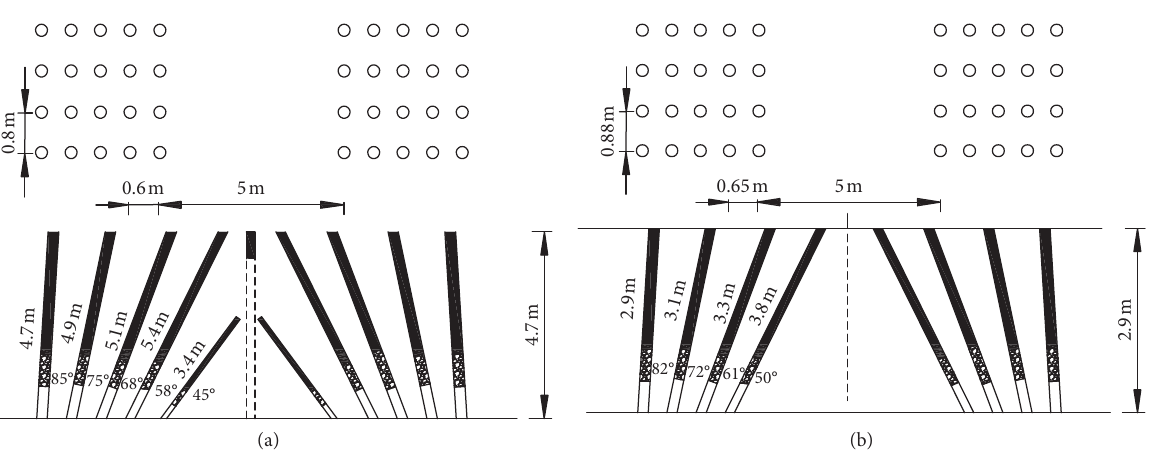
Figure 10: Cuthole arrangement in (a) grade III (arrangements of cutting holes in class III rocks) and (b) grade IV rocks (arrangements of cutting holes in class IV